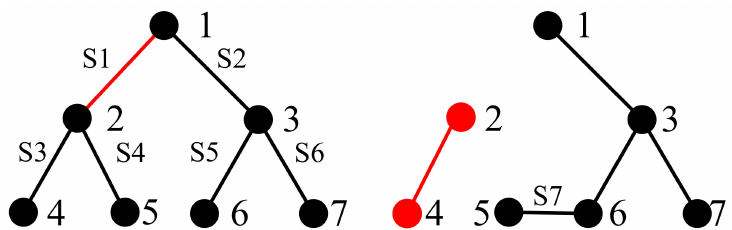
Figure 7. A simple example of failure restoration in the distribution network (the red line represents the de-energized